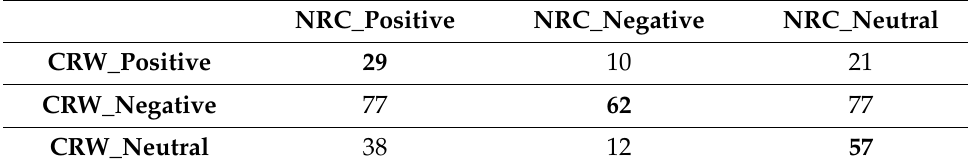
Table 4. Confusion matrix: NRC vs. CRW.